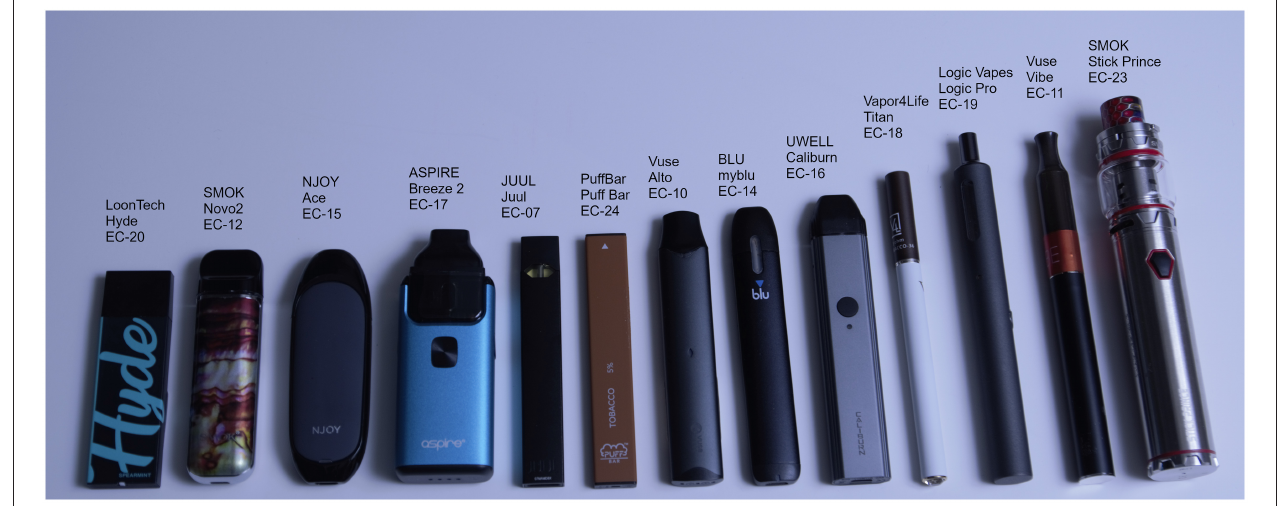
FIGURE 1 | Image of the thirteen ENDS products tested for this